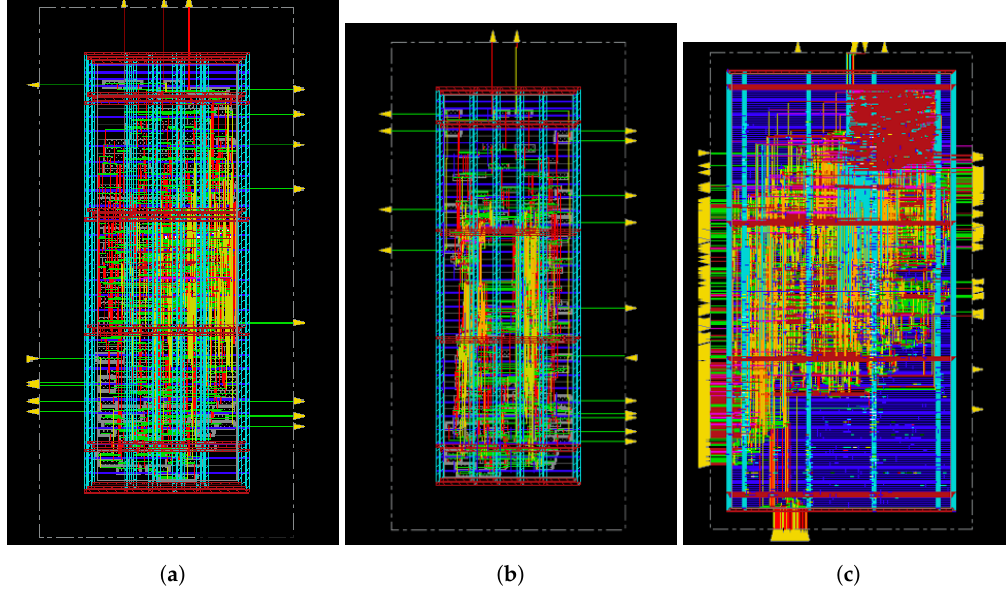
Figure 10. Floorplans of RISC _ core and 256 tap FIR filter after proposed algorithm under various aspect ratio. ( a ) 256 tap FIR with 3:1 with one voltage island; ( b ) 256 tap FIR filter in 2:1 with one voltage island; ( c ) 3:1 layout of RISC _ core with two voltage